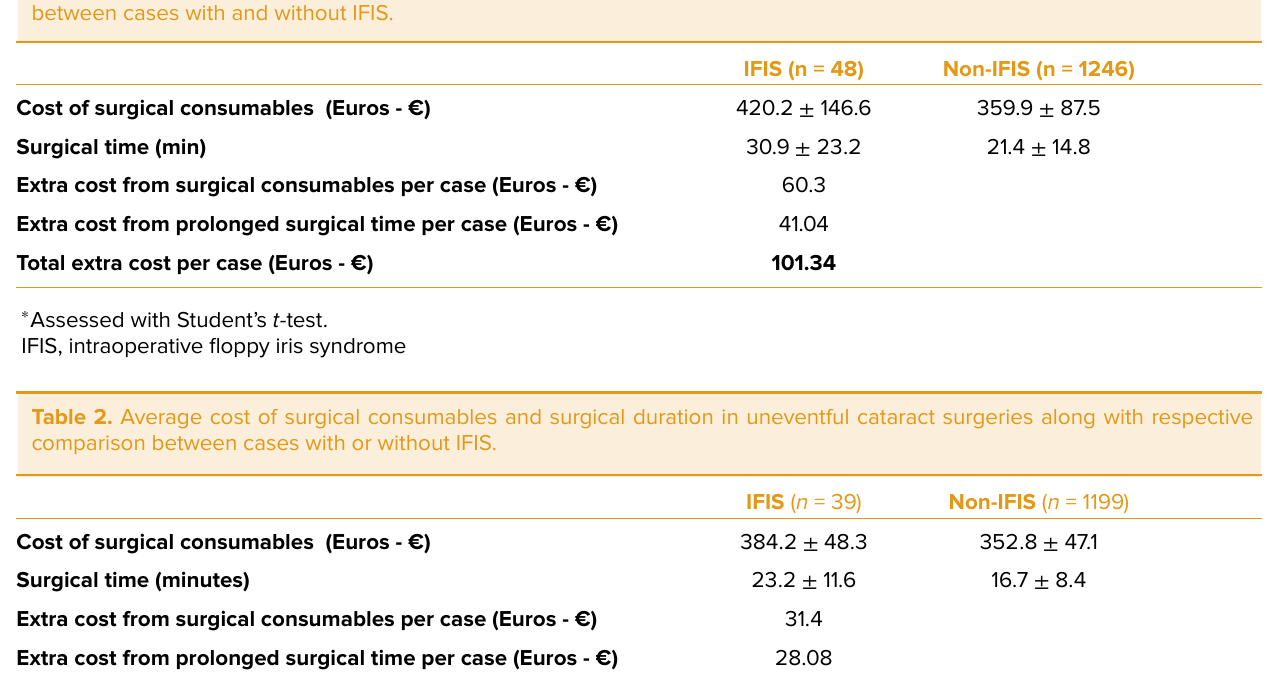
Table 1. Average cost of surgical consumables and surgical duration in all cataract surgeries along with respective comparison between cases with and without IFIS.